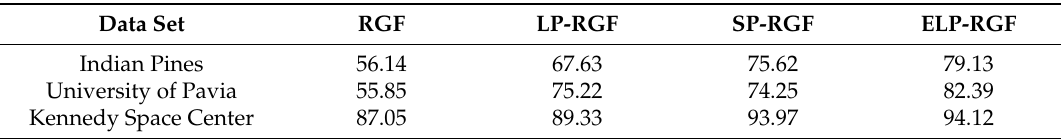
Figure 12. The process of modifying the wrongly-labeled samples. ( a ) The five wrongly-labeled pseudo-labeled samples are provided; ( b ) shows that the first and second labels of pseudo-labeled have been modified by superpixel propagation; ( c ) shows the real labels of the provided wrongly-labeled pseudo-labeled samples. Table 6. Overall accuracy of the various combined methods involved in the proposed method for three